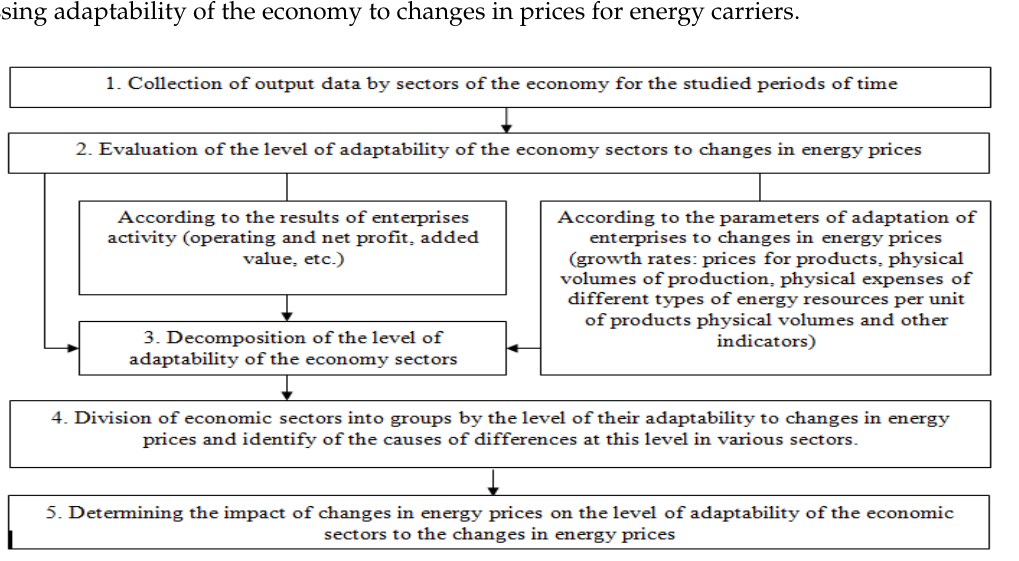
Figure 2. The sequence of assessing the adaptability of the economy to the changes in energy prices.